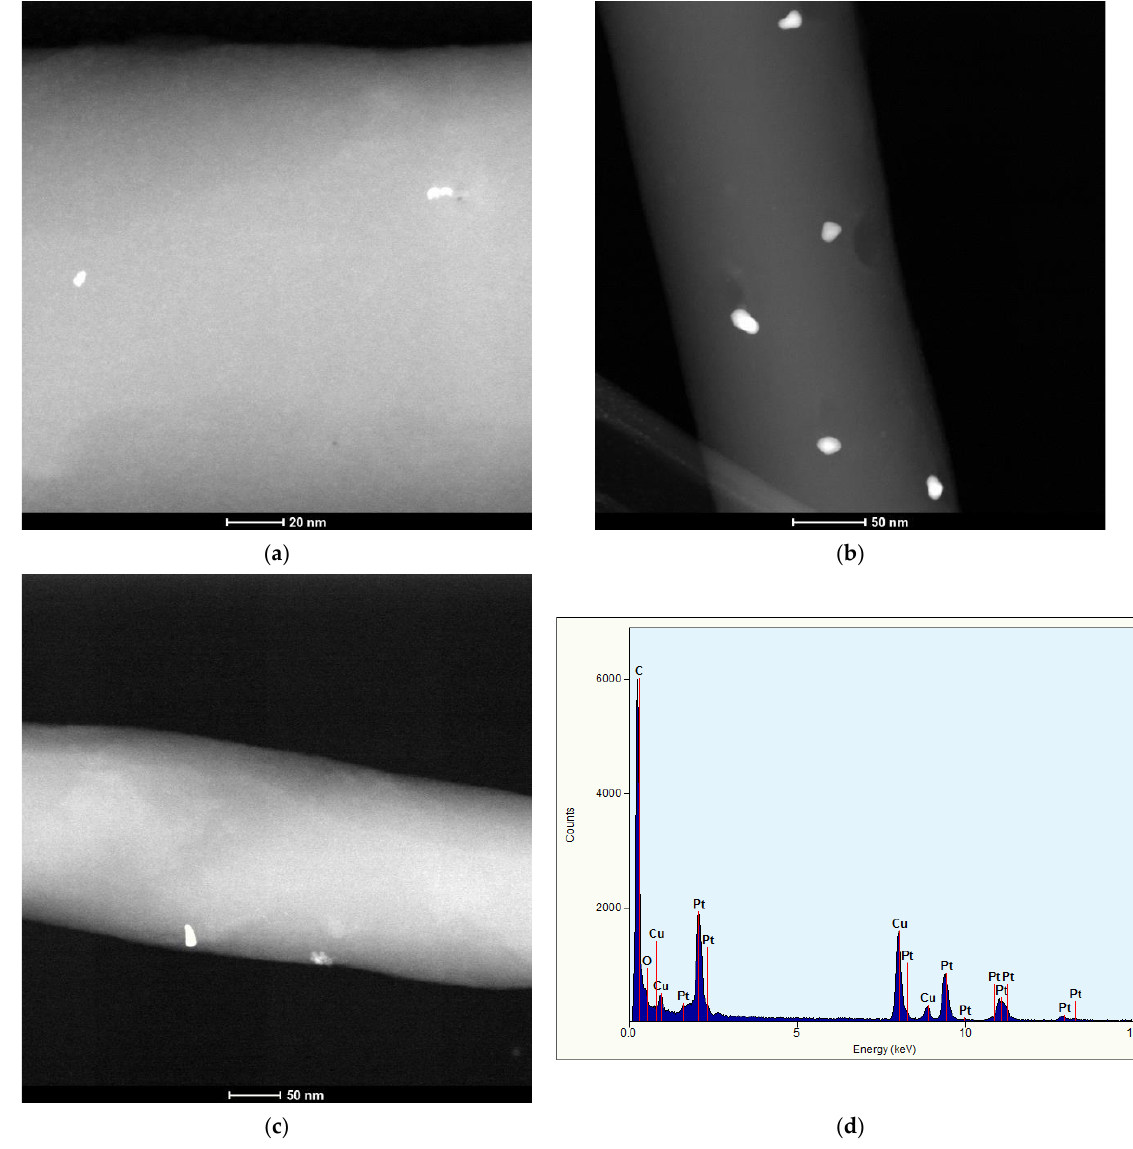
Figure 7. The STEM micrographs of the catalytic electrospun membranes. ( a ) 0.08 Pt/PBI, ( b ) 0.54 Pt/PBI, ( c ) 0.68 Pt/PBI, ( d ) typical EDX spectrum of an typical Pt NP (signal of Cu originates from the Cu TEM grid used).